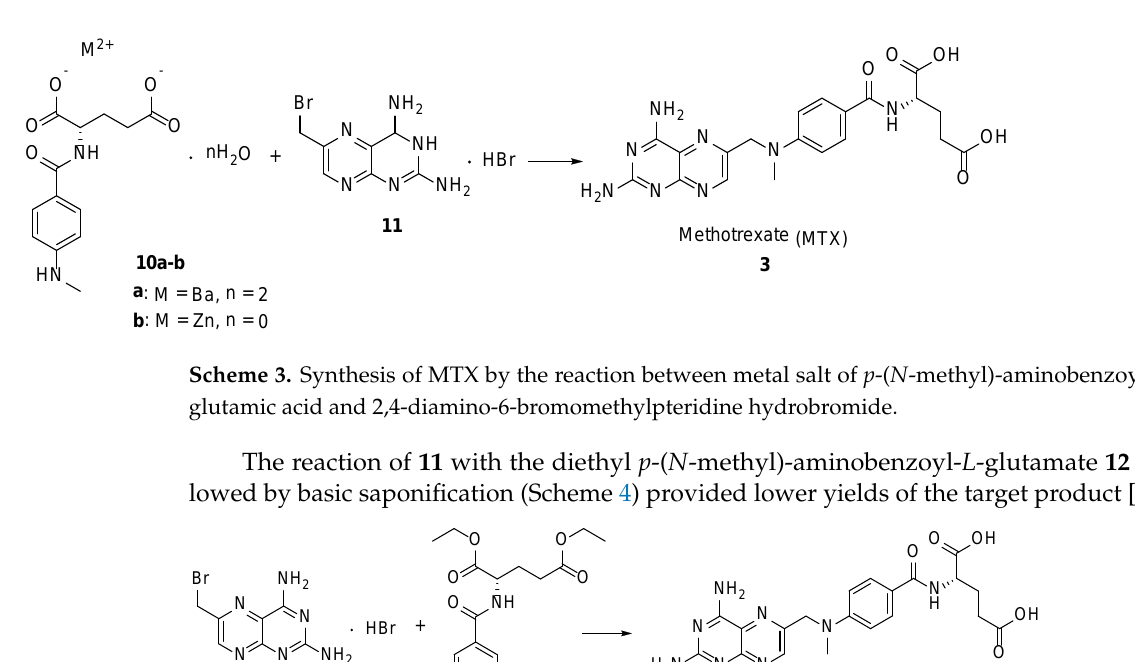
Scheme 4. Synthesis of MTX by the reaction of 2,4-diamino-6-bromomethylpteridine hydrobromide 11 with diethyl p -( N -methyl)-aminobenzoyl- L -glutamate 12 .